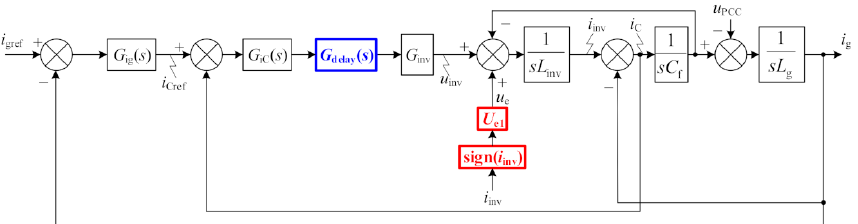
Figure 7. The closed loop control structure block diagram of the converter considering dead-time effects and digital control delay.